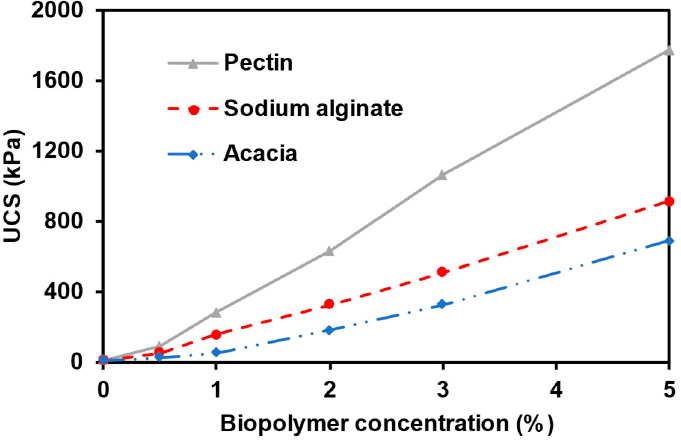
Figure 2. Effect of the biopolymer concentration on the UCS after a curing period of seven days.